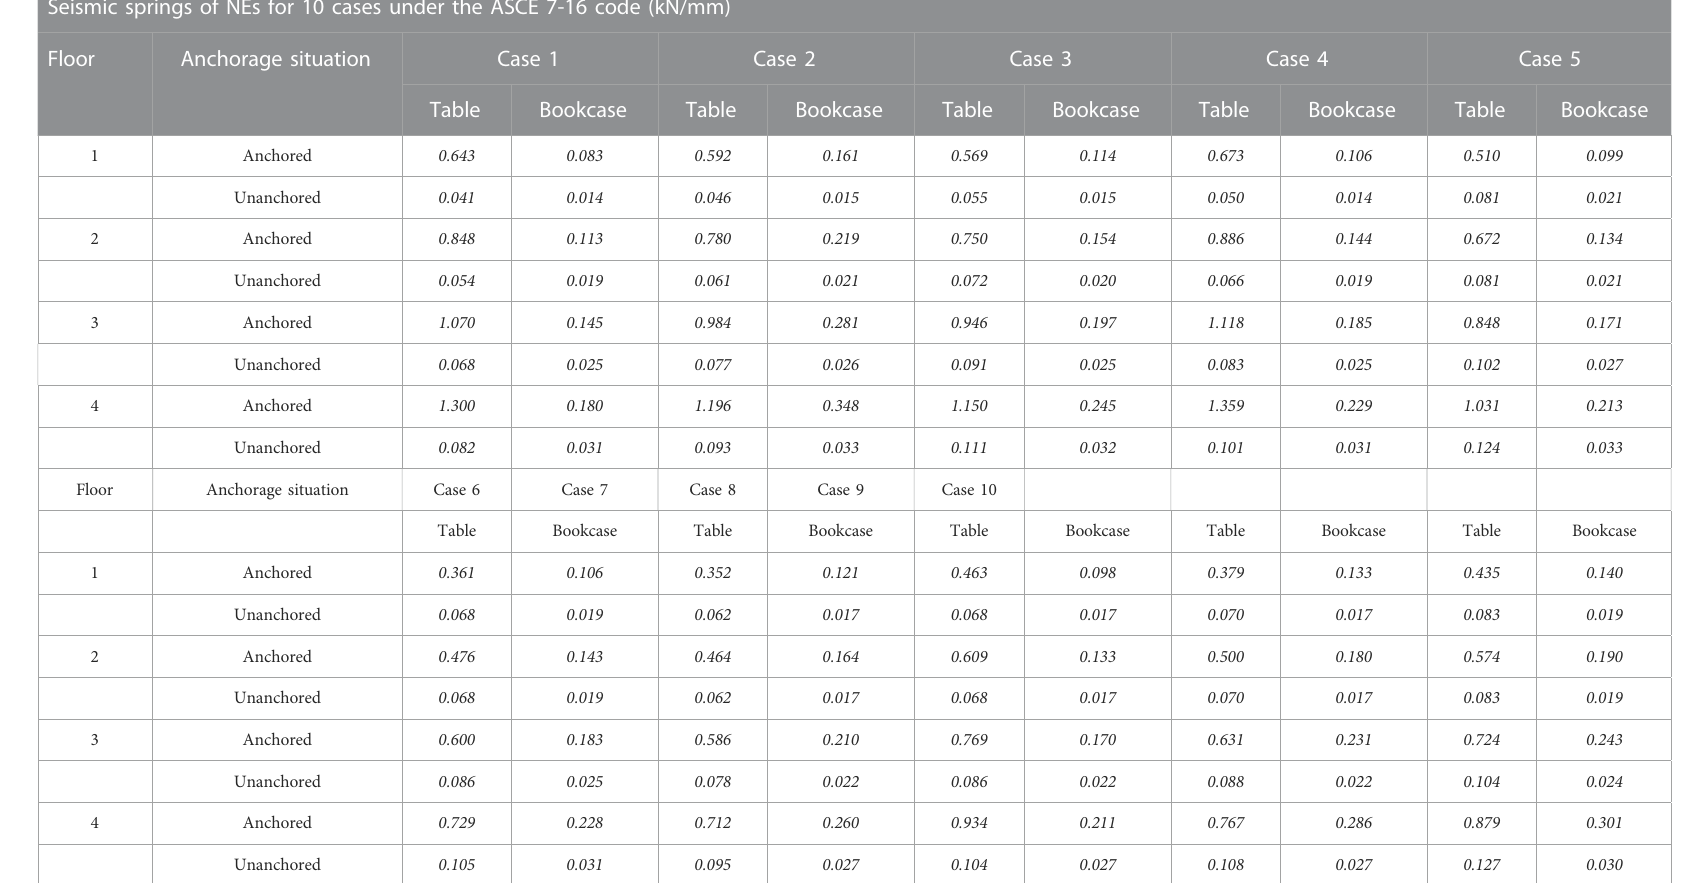
TABLE 10 Calculated seismic stiffness parameters of NEs for 10 different cases under the ASCE 7-16 code (Cavuslu, 2022). Seismic springs of NEs for 10 cases under the ASCE 7-16 code